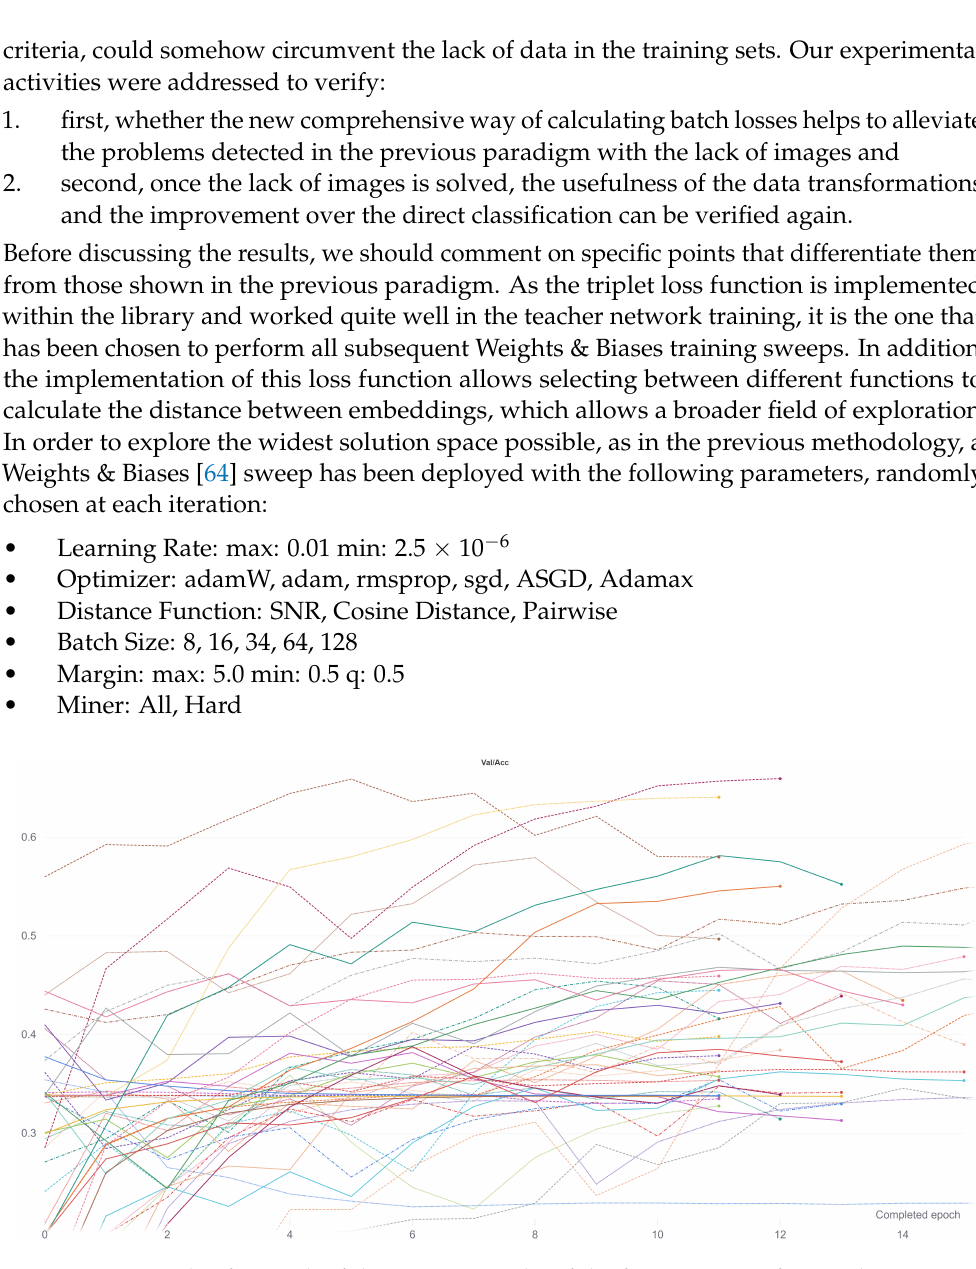
Figure 16. Example of a graph of the training results of the first 100 runs of a Weights & Biases sweep. The plot shows on the ordinates axis the Validation Set, Accuracy metric used to evaluate the performances of our system. As the reader will notice, slightly different parameters lead to considerable differences in the accuracy metric values.